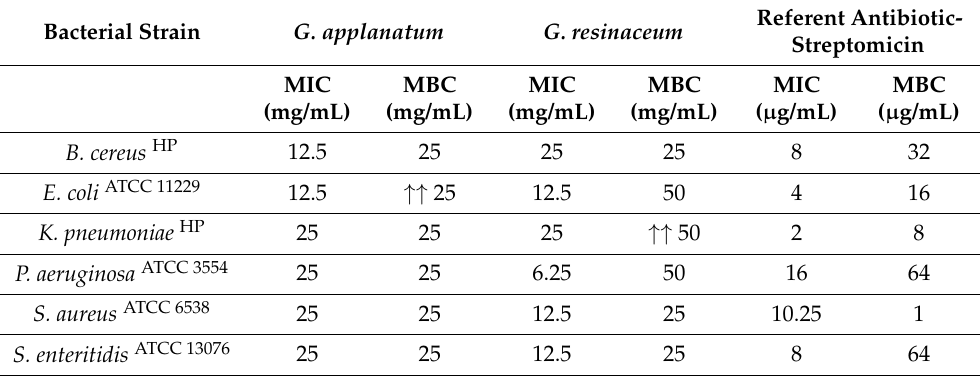
Table 3. Antibacterial activity of CHCl 3 extracts of G. applanatum and G. resinaceum using microdilu- tion